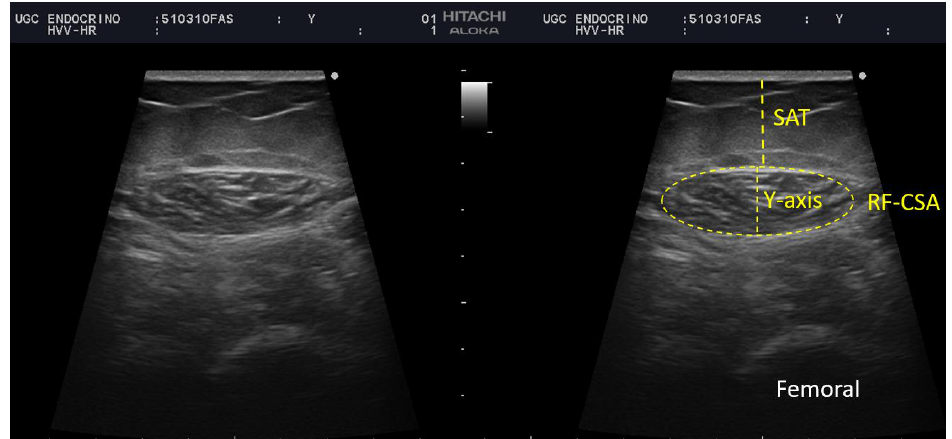
Figure 1. Measurement of rectus femoris (RF) and subcutaneous adipose tissue at leg level by ultrasound of a participant of our sample. BRF-CSA—cross-sectional area (CSA), muscle thickness (or Y-axis), SAT—subcutaneous adipose tissue.